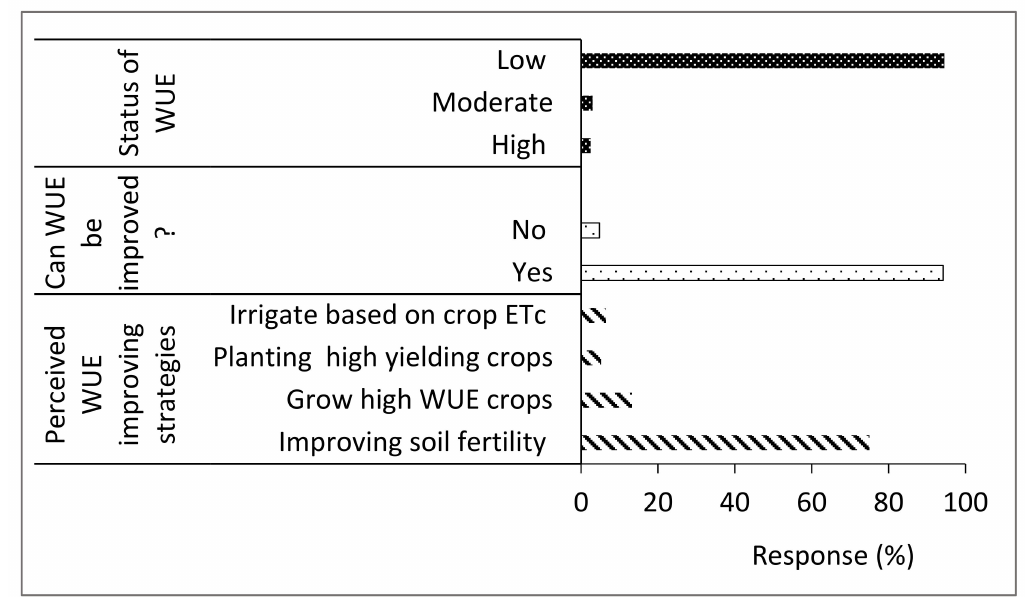
Figure 6. WUE as perceived by respondents (ETc = crop water requirement).